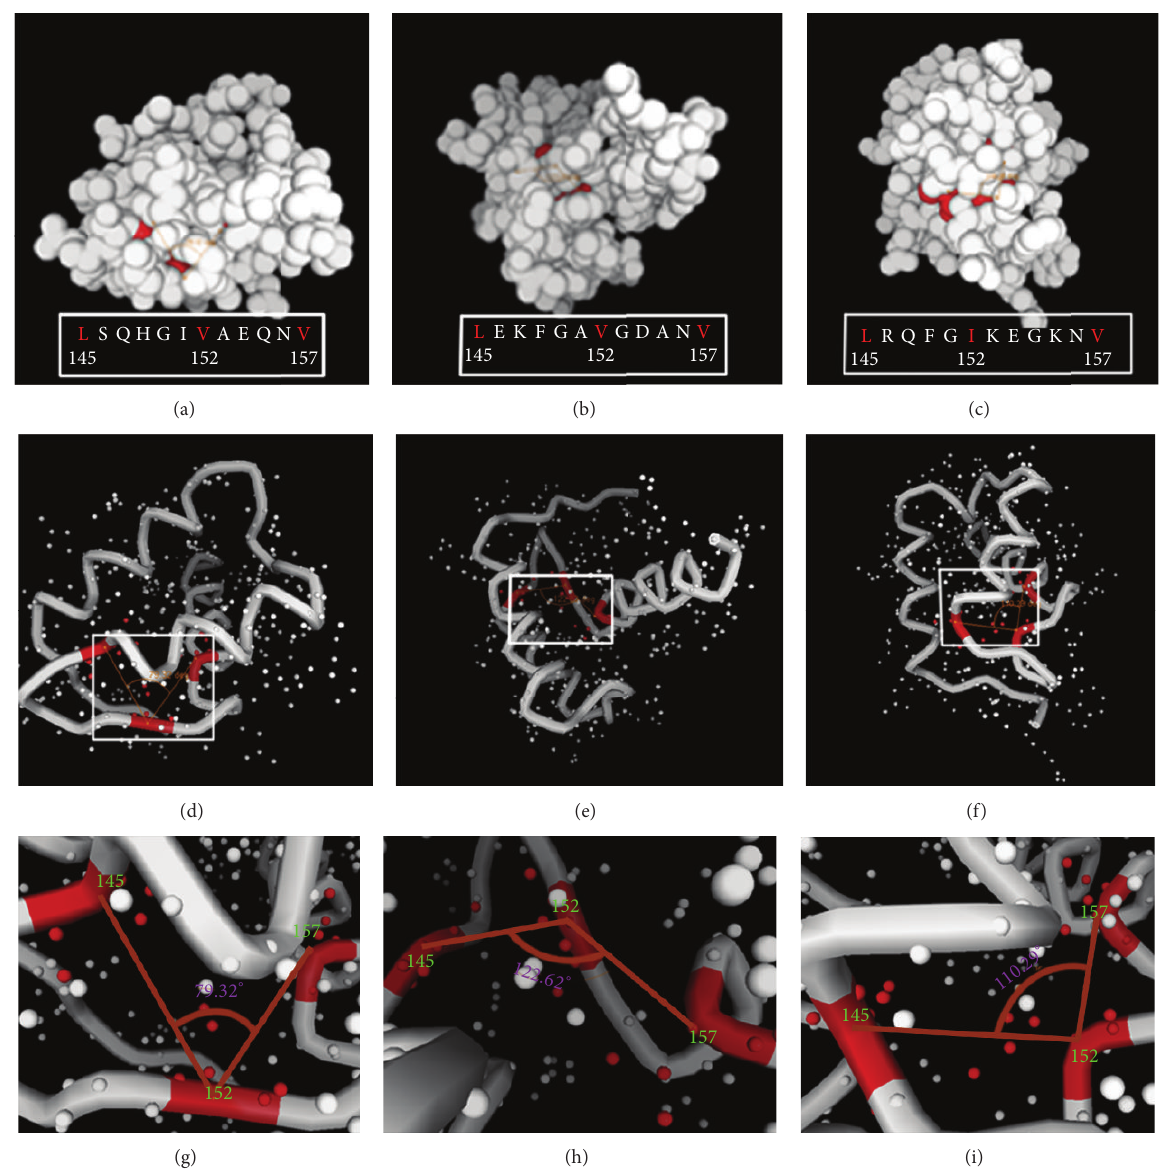
Figure 6: 3D structures of the homeodomain in different clades of WOXs. All the WOX proteins had 3 conserved residues in the homeodomain: 145 (L), 152 (V/I), and 157 (V). The 3 residues formed an angle in (a), (d), and (g) 3D structures of ancient clade proteins (WOX13): (b), (e), and (h) 3D structures of intermediate clade proteins (WOX11); (c), (f), and (i) 3D structures of WUS clade proteins (WUS); 79.32 deg, 122.62 deg, and 110.29deg,